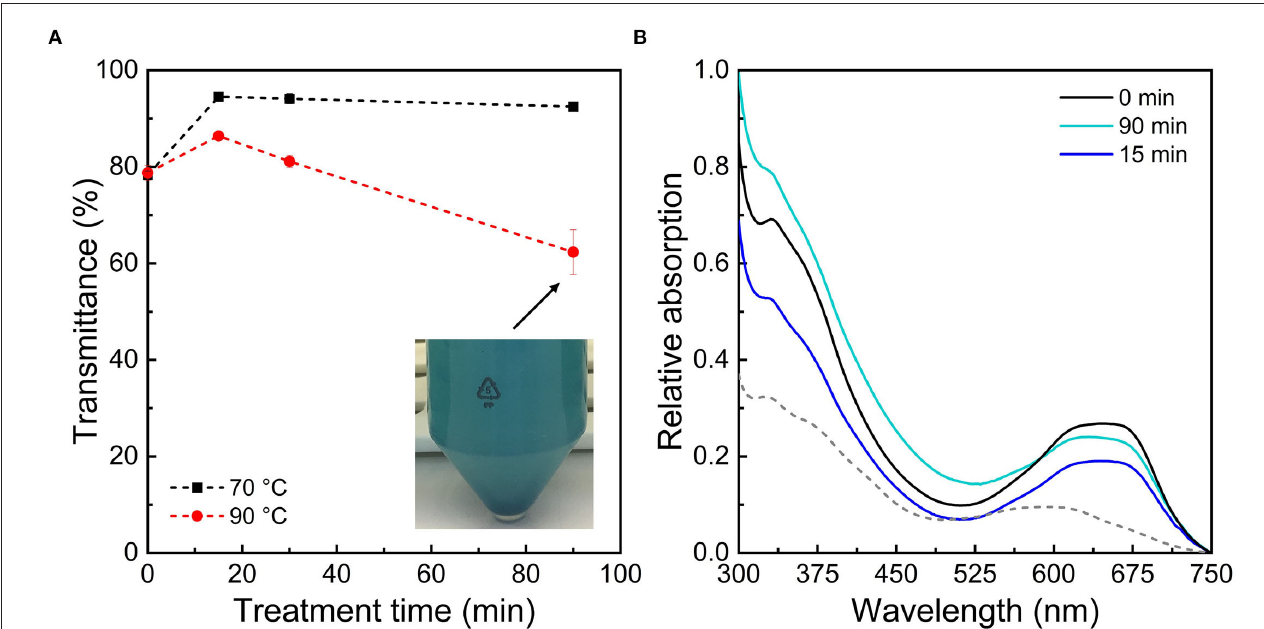
FIGURE 4 | (A) Relative transmittance of PC: λ C (1:4) complexes prepared at pH 3.0 stored for 14 days at 25 ◦ C after heat treatments to 70 and 90 ◦ C plotted over ultrasonication treatment time. (B) Relative absorption of PC: λ C complexes heated to 90 ◦ C at pH 3.0 with a subsequent storage of 14 days at 25 ◦ C after different ultrasonication treatment times. The absorption of PC: λ C complexes prepared with untreated λ C at pH 6.0, heated to 90 ◦ C and stored for 14 days (25 ◦ C) is plotted as dotted line.